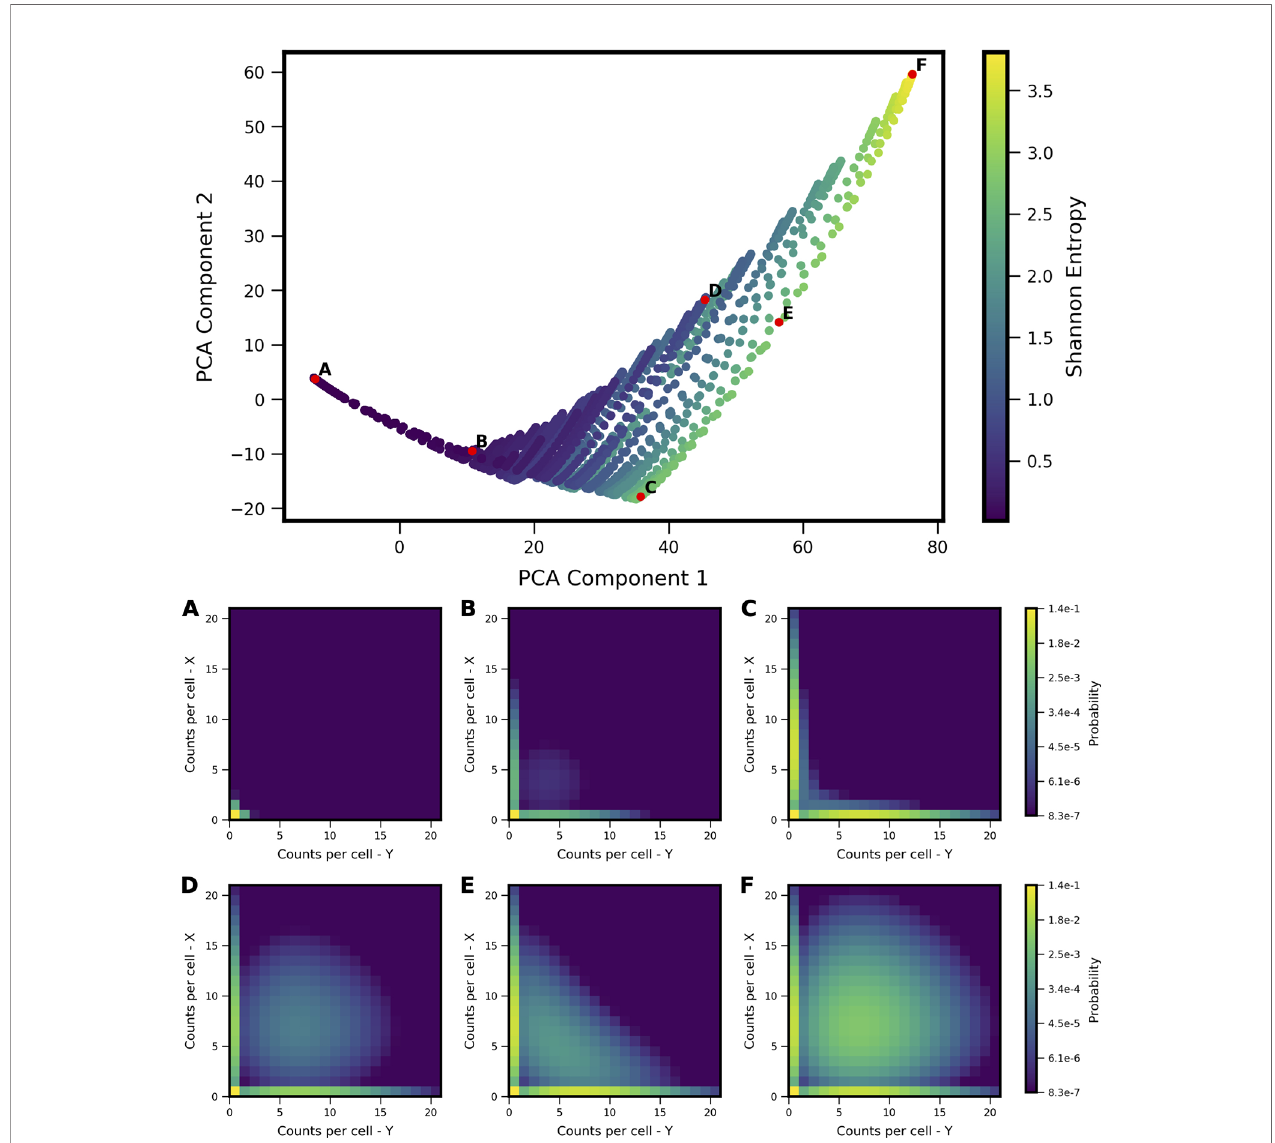
FIGURE 5 | Shape-space of simulated MISA coexpression landscapes analyzed by Principal Component Analysis (PCA). Coexpression landscapes were computed for 22,718 unique two-gene stochastic network models with Mutual Inhibition/Self-Activation (MISA) logic and varying kinetic rate parameters. Promoter-state change rates were restricted to the fast regime (see Table 1 ). (Top) All model landscapes projected onto the fi rst two principal components. Each dot corresponds to one model, colored by the model's Shannon Entropy. (Bottom) Representative quasipotential landscapes f (n) (see Text) of individual models from different regions of PCA component-space. Color of each discrete grid space in {x, y} corresponds to computed probability (in log-scale) to fi nd a single cell with the corresponding numbers of {x,y} transcripts. (Analogous to Figure 2 ). Each landscape is labeled (A – F) to indicate the corresponding point where it appears in PCA space